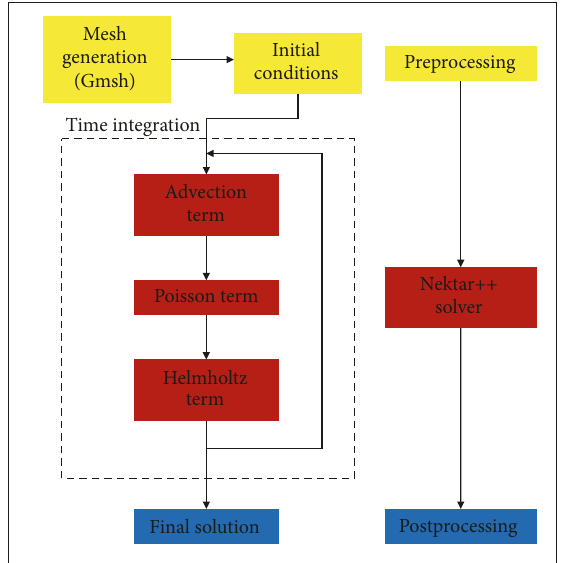
Figure 4: Contours of velocity component in the 𝑥 direction and streamlines at Re = 40.